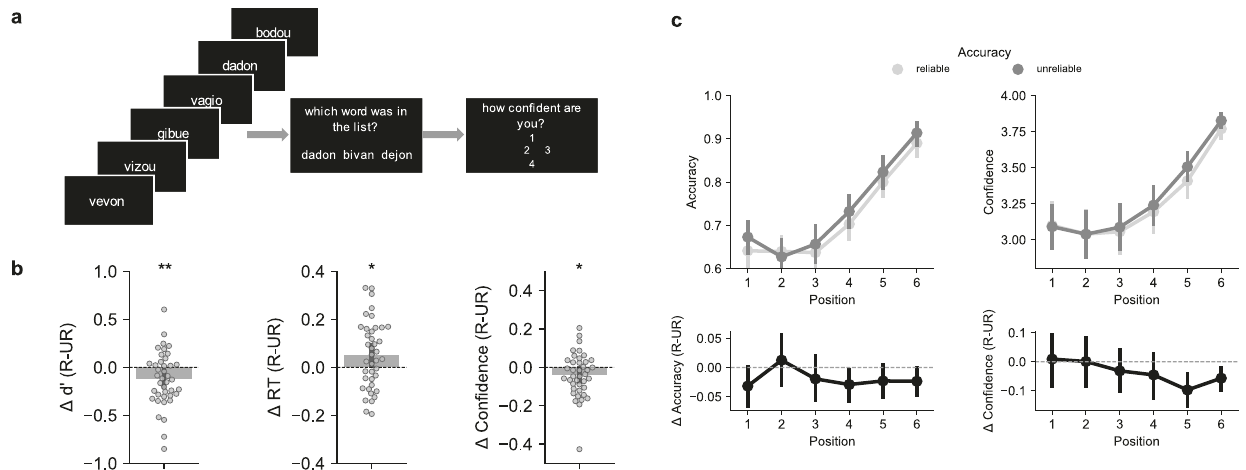
Fig. 5 Automatic impact of the common prosodic signature on verbal working memory (study 3). a Design of the memorization task. Participants heard six spoken pseudo-words before having to recognize a target pseudo-word presented along with two distractors. Unbeknown to the participant, the spoken targets were pronounced with the archetypes of prosodies derived from Study 1 and were either reliable (certain or honest) or unreliable (lie or doubt), while the prosody of the fi ve spoken distractors was randomly picked from the same pool of stimuli, ensuring equal saliency of the target and distractors. b Main results of the memory task. Differences ( Δ ) between d ’ (left), response times (middle) and con fi dence (right) for reliable minus unreliable prosodic archetypes. Data are presented as mean values with error bars showing the 95% con fi dence interval. Dots show individual data. Unreliable prosodies were memorized better and faster than reliable prosodies and were associated with more con fi dent ratings. Black asterisks show the results of the two-sided paired t tests comparing reliable and unreliable prosodies, with ** p = 0.01; * p < 0.05; d ’ : p = 0.01; response times: p = 0.026; con fi dence: p = 0.035. c Recency effect. Top: accuracy (top left) and con fi dence (top right) for reliable (light gray) and unreliable (dark gray) prosodic archetypes as a function of the position of the target within the audio stream. Bottom: differences between reliable minus reliable prosodic archetypes (black). There was no main interaction between position and prosody for accuracy, but the impact of prosody on con fi dence judgments interacted with target position such that recent unreliable targets lead to increased con fi dence. Data are presented as mean values with error bars showing the 95% con fi dence interval; * p < 0.05; ** p = 0.01. Source data are provided as a Source data fi